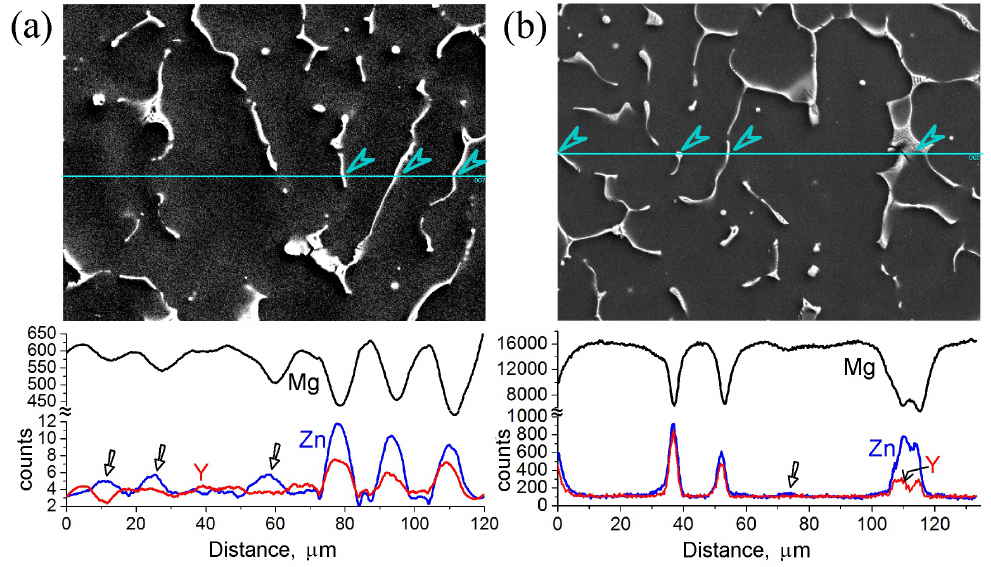
Figure 7. Backscattered electron SEM micrographs from the center of the castings of ( a ) chill cast and ( b ) conventional molds. EDS line scan were made along the horizontal line drawn (arrowheads show the ternary phase on the line). The concentration profiles of Mg, Zn and Y along the line are plotted below each micrograph. Arrows indicate local zinc